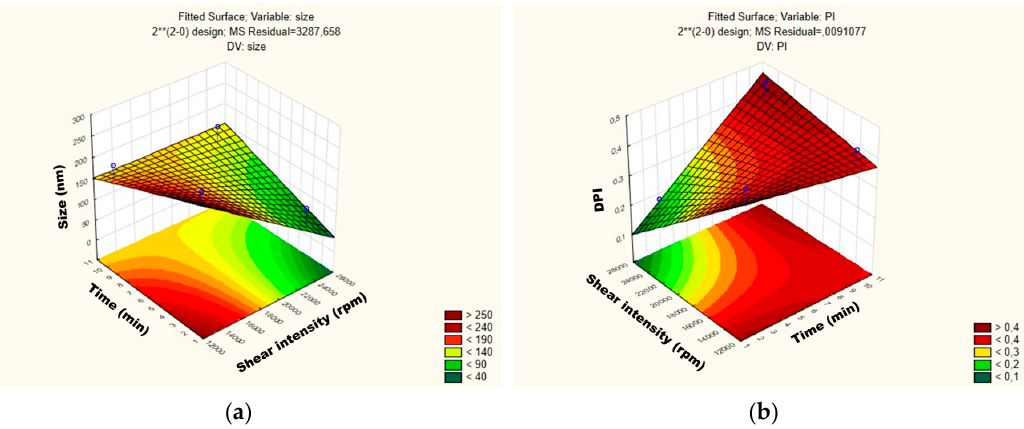
Figure 3. Surface response charts of experimental design of the placebo obtained for ( a ) particle size (Z-average) and ( b ) polydispersity index (PDI).